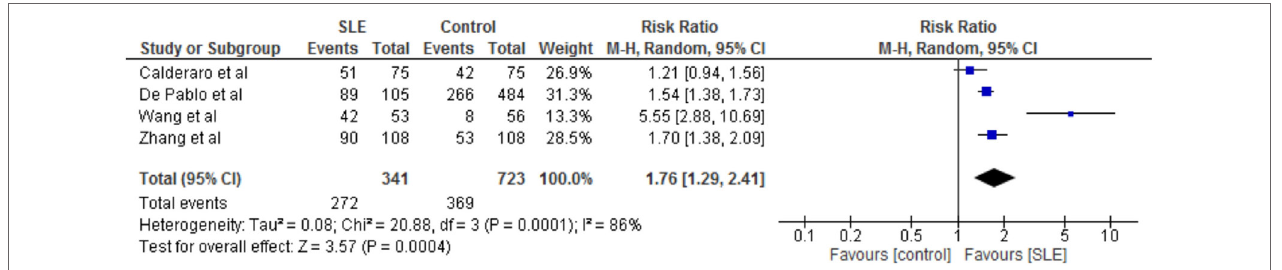
FigUre 2 | Forest-plot representing risk ratio of periodontitis between cases with systemic lupus erythematosus (SLE) and healthy controls.